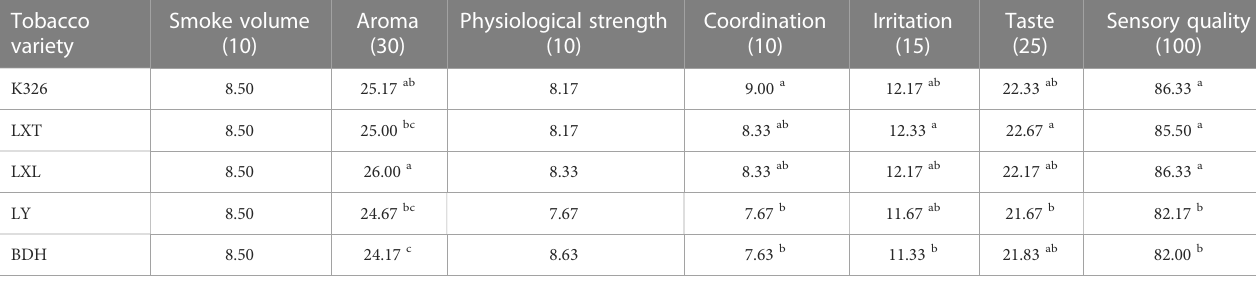
TABLE 1 Comparison of the mean scores of six sensory attributes and overall quality for fi ve tobacco varieties in sensory evaluation. Tobacco variety